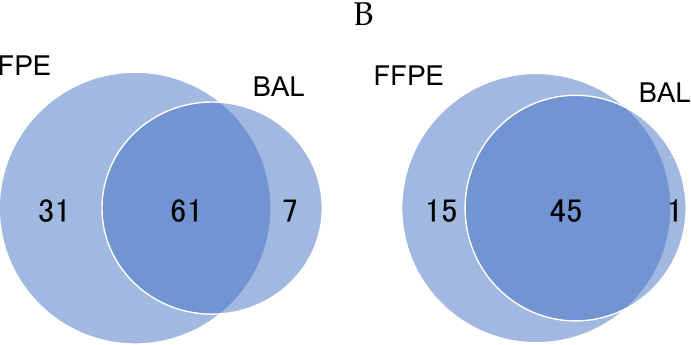
Figure 5. Venn diagram indicating the mutational overlap between formalin-fixed paraffin-embedded (FFPE) and bronchoalveolar lavage (BAL) samples. ( A ) All mutations; ( B ) oncogenic mutations.